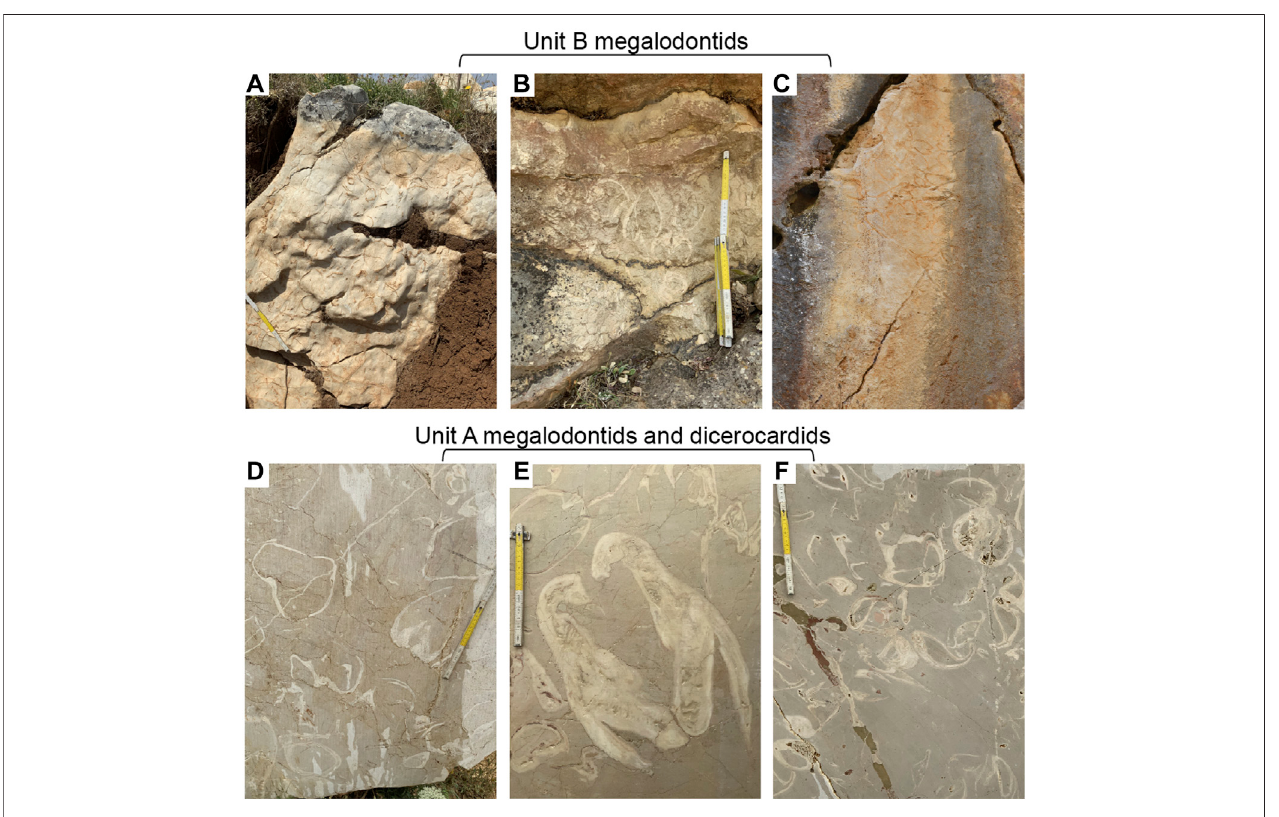
FIGURE 2 | Megalodontoids association in the Mt Sparagio section. (A) , (B) and (C) small megalodontids association in Unit B. (D – F) common presence of large megalodontids and dicerocardids shells in Unit A.